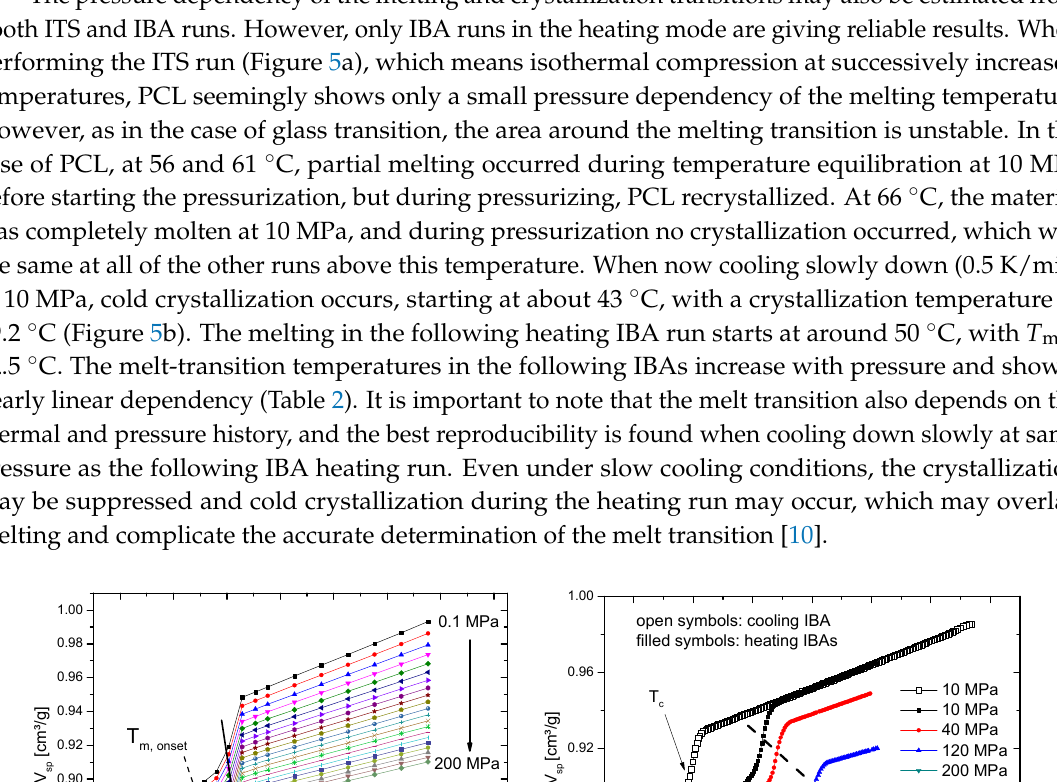
Figure 4. Selected isobars of Figure 3b in comparison with directly measured isobars (Figure 2a, legend gives pressure in MPa).